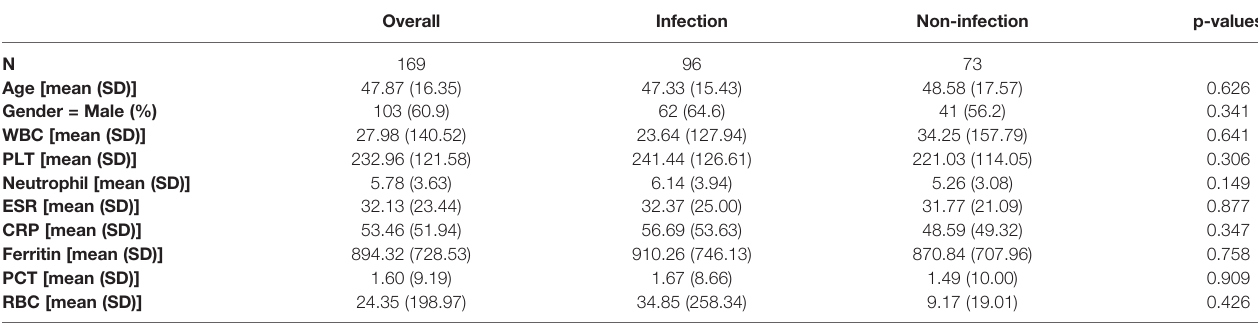
TABLE 2 | The baseline of enrolled